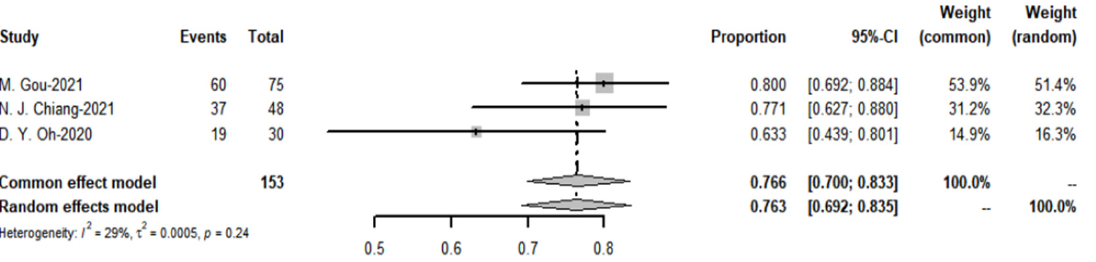
Figure 19. Objective response rate of targeted therapies.